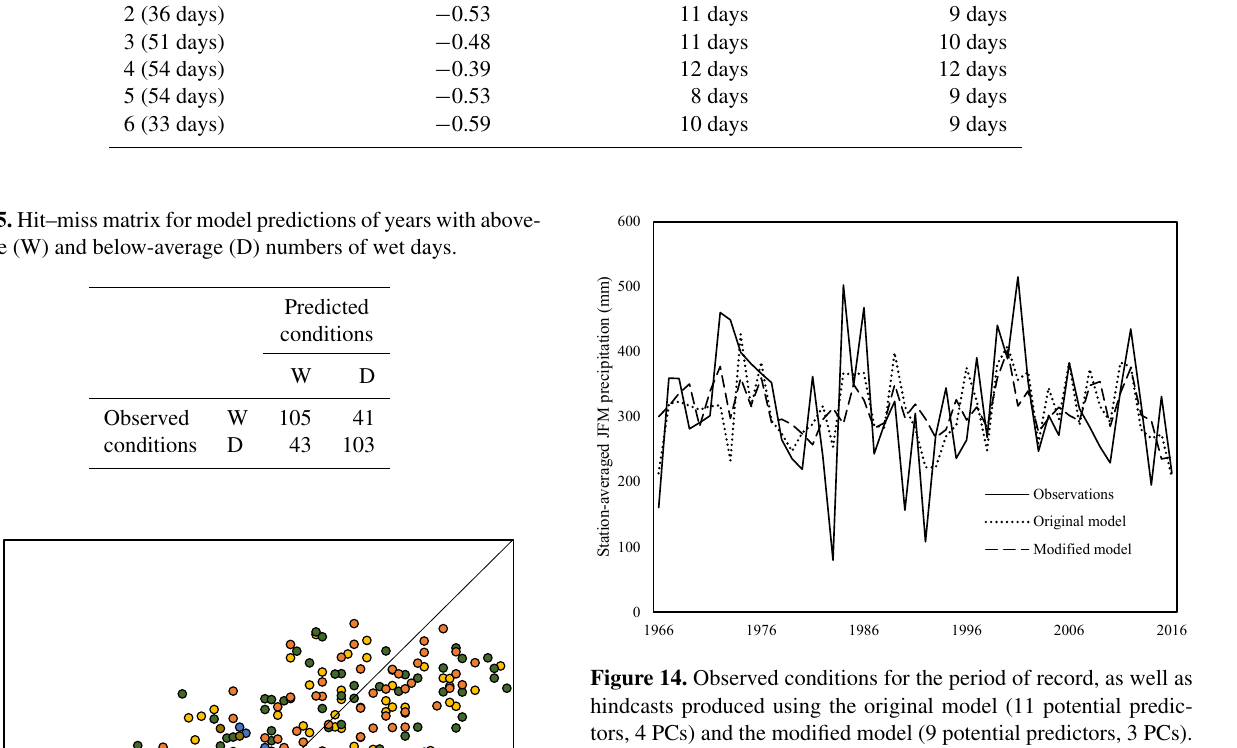
Table 4. Correlation values and average absolute errors for predictions of wet days at each station. Station Correlation value ( r ) Average absolute error in Average absolute error in (average number between prediction years with above-average years with below-average of wet days) and observation number of wet days